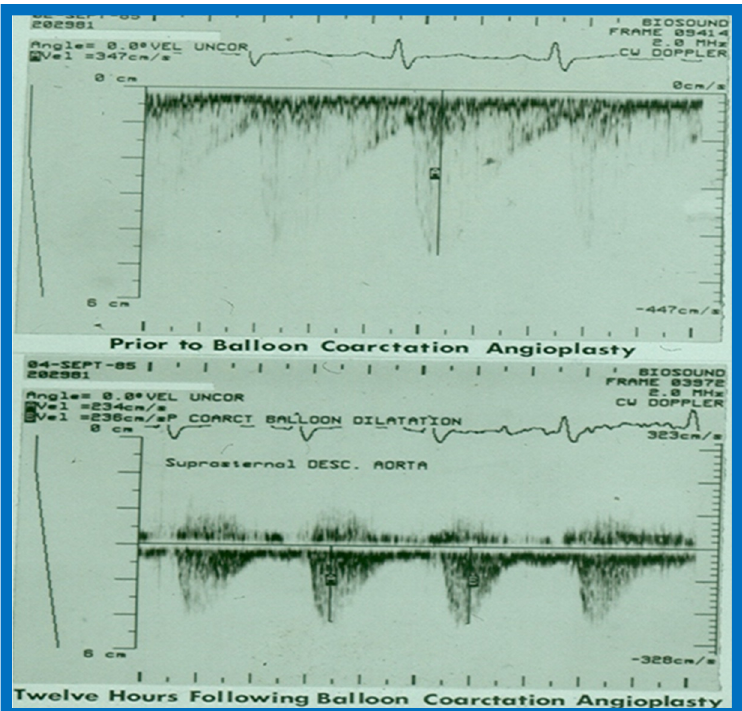
Figure 53. Continuous wave Doppler flow velocity recordings from suprasternal notch view directing the Doppler signal towards the descending aorta prior to (top) and twelve hours following (bottom) balloon angioplasty of aortic coarctation. Note the reduction of peak Doppler flow velocity from 3.47 m / s to 2.35 m / s after balloon angioplasty. Also note that the pandiastolic flow seen prior to angioplasty is no longer seen after angioplasty. Reproduced from Rao P.S. [17].